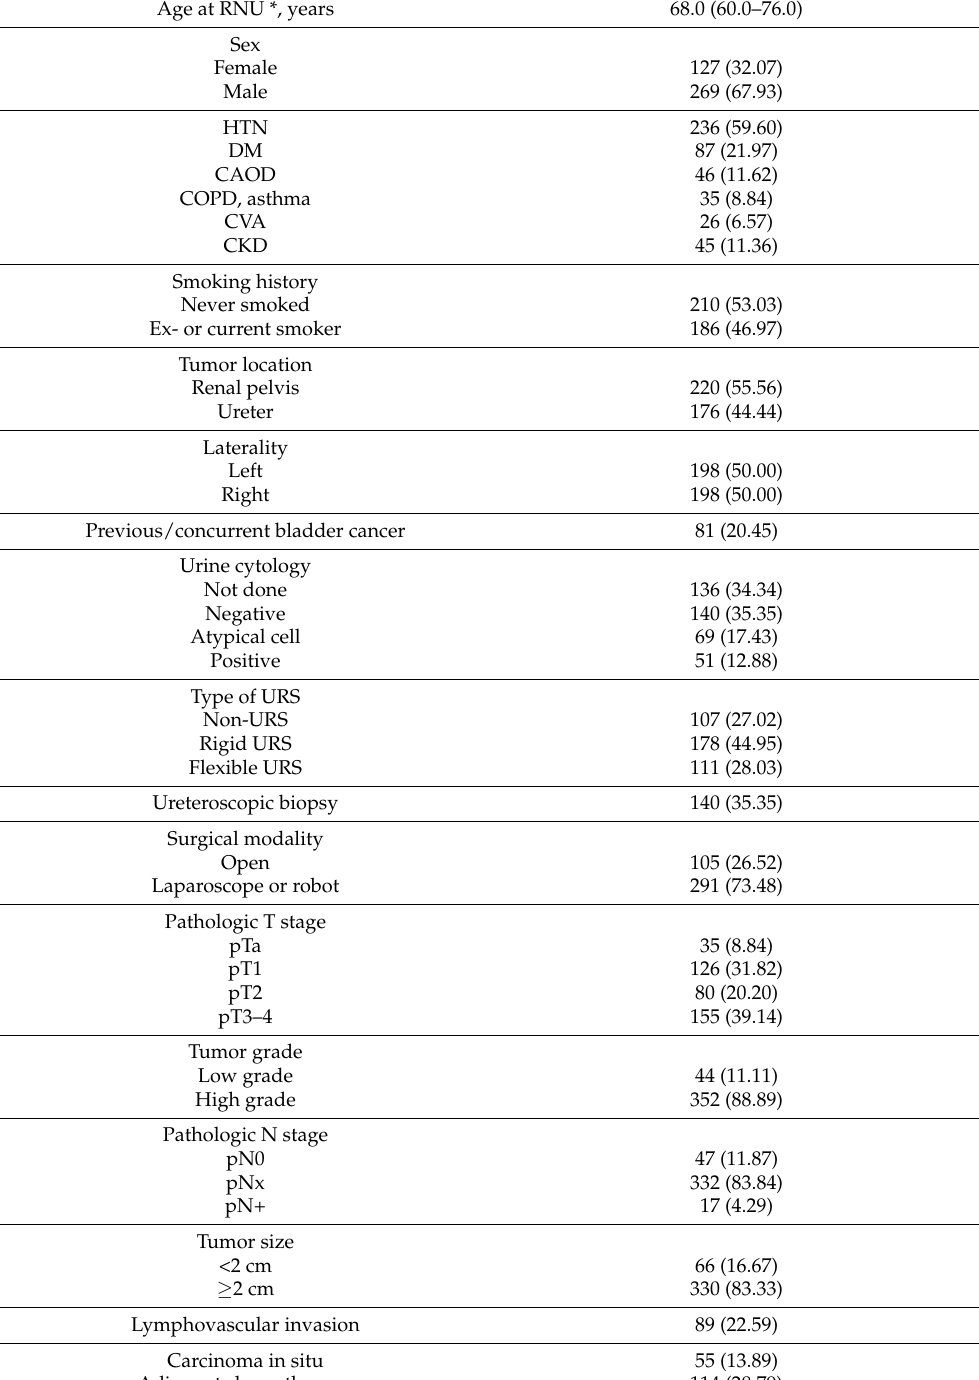
Table 1. Clinicopathological characteristics of 396 patients with